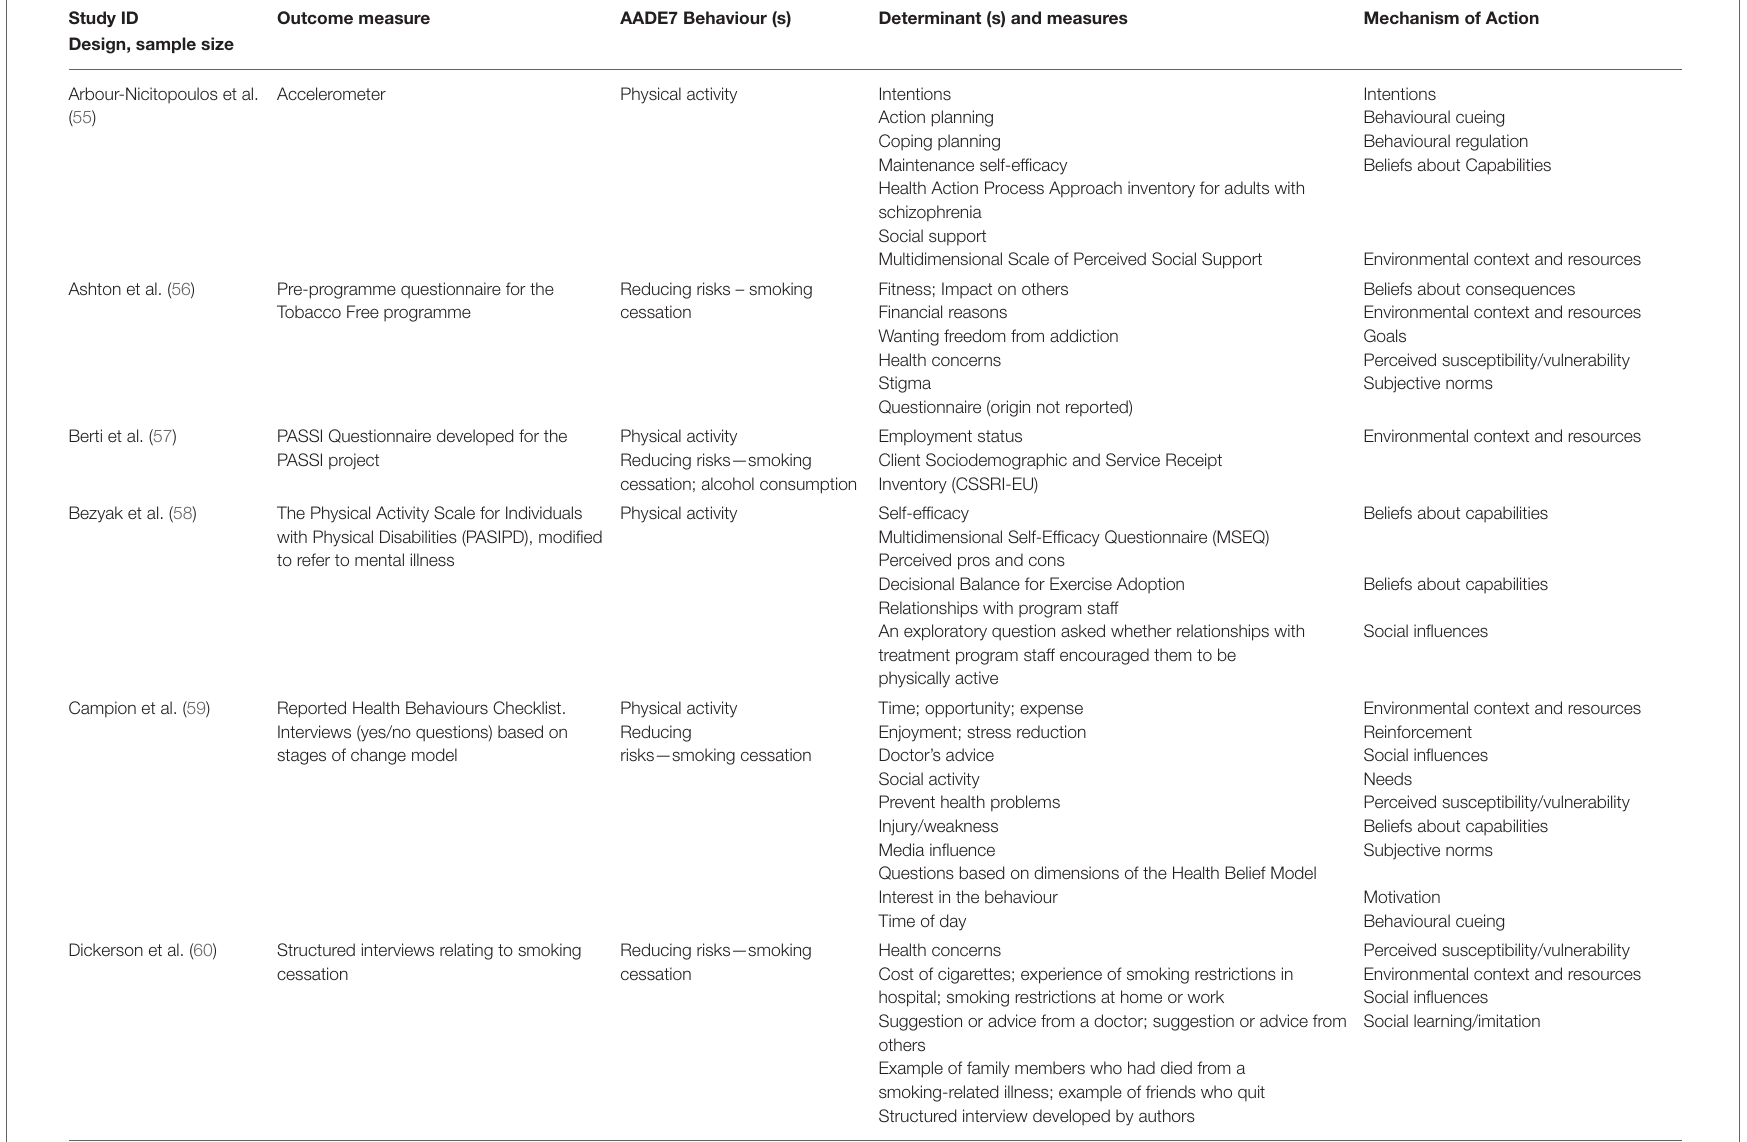
TABLE 5 | Links between outcomes and AADE7 self-management behaviours and between measured determinants and MoAs. Study